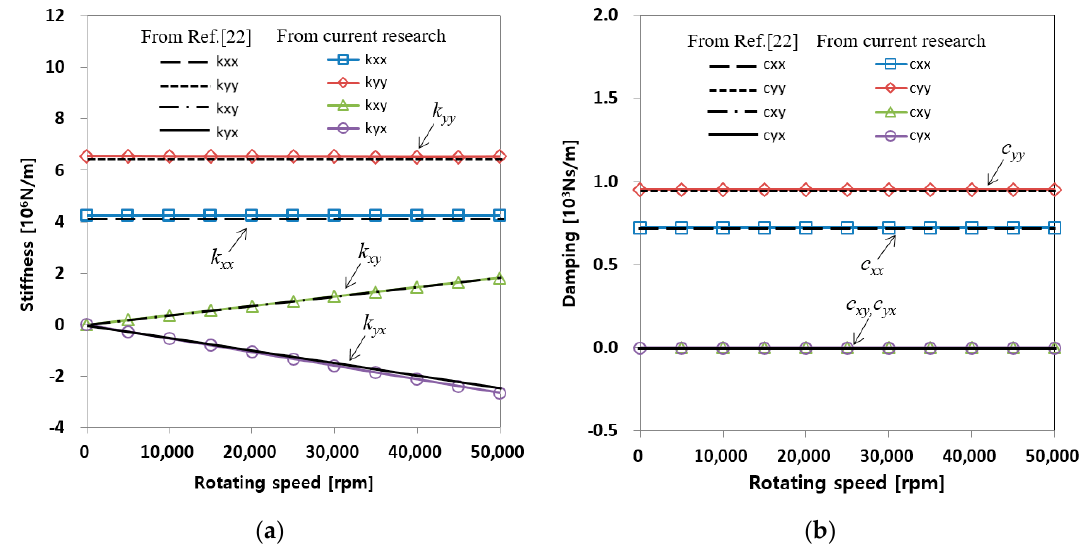
Figure 4. Stiffness and damping for hydrostatic radial bearing in [22]. ( a ) Stiffness; ( b ) Damping. Figure 4. Sti ff ness and damping for hydrostatic radial bearing in [22]. ( a ) Sti ff ness; ( b )